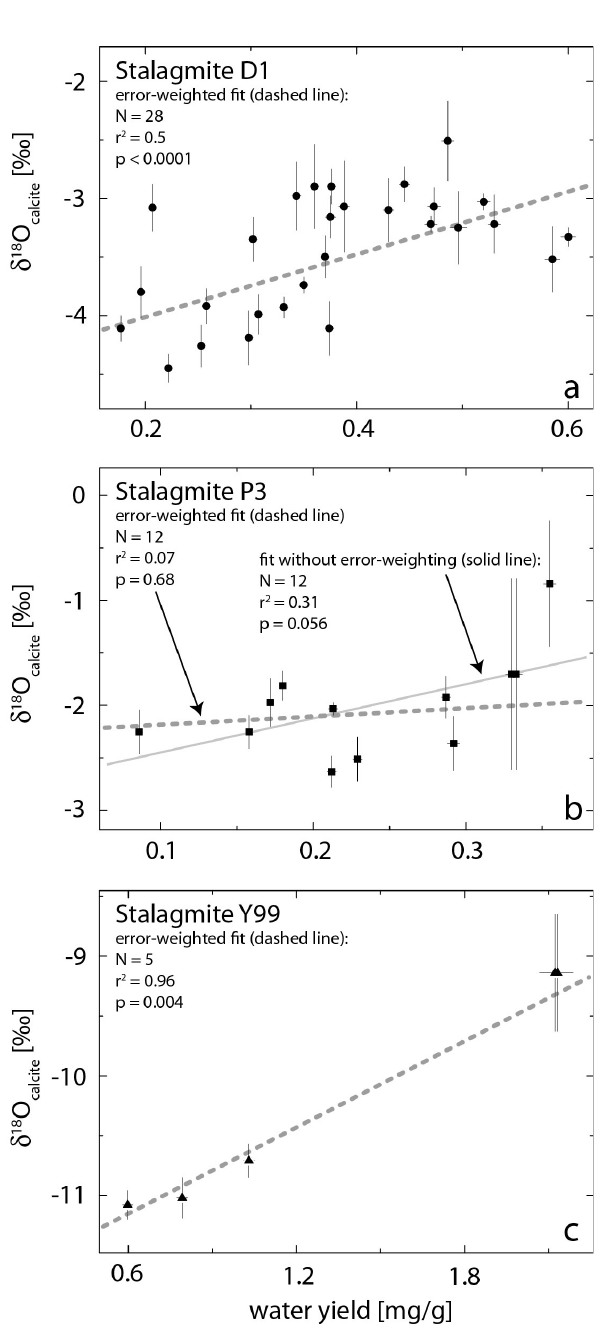
Fig. 6. Correlation between water yield and δ 18 O calcite for stalag- mites D1 (a) , P3 (d) , and Y99 (c) . Water was extracted at 320 ◦ C for D1 and P3 samples, and at 400 ◦ C for Y99 samples. Dashed lines represent error-weighted fits; the solid line in Fig. 6b represents a non-error-weighted fit. N = number of data points; r 2 = coefficient of determination; p = significance level. Error bars of δ 18 O calcite values represent standard errors of mean values. Error bars associ- ated to water yield data (see Table 2 and Sect. 2.4) are often smaller than the symbol